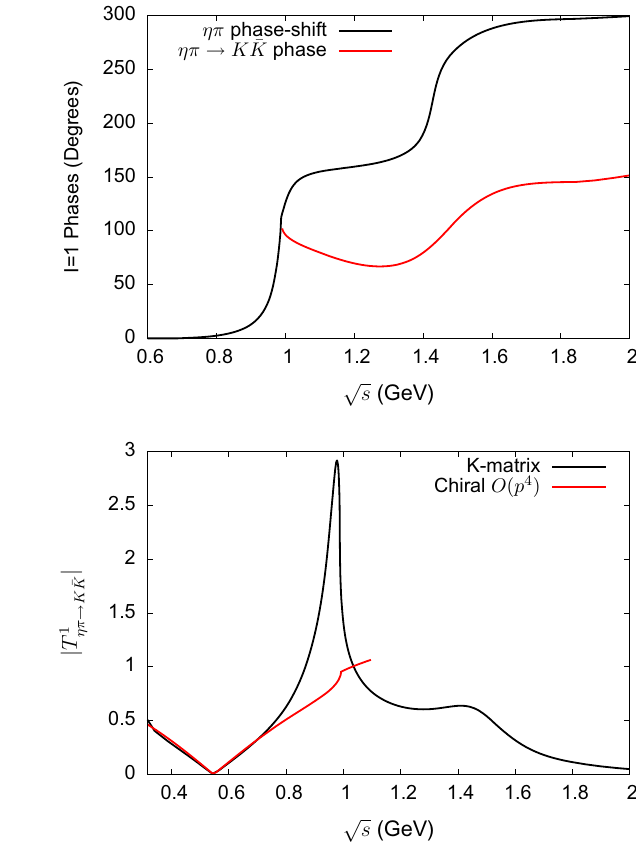
Fig. 2 Illustration of the I = 0 T -matrix used. The upper figure shows the ππ phaseshift( uppercurve )andthephaseofthe ππ → K ¯ K ampli- tude g 0 ( lower curve ). The dotted line is the phase used for computing 0 the one-channel Omnès function. The lower figure shows the modulus of g 0 . The curve is a fit to the data above the K ¯ K threshold and an 0 extrapolation, based on analyticity, below